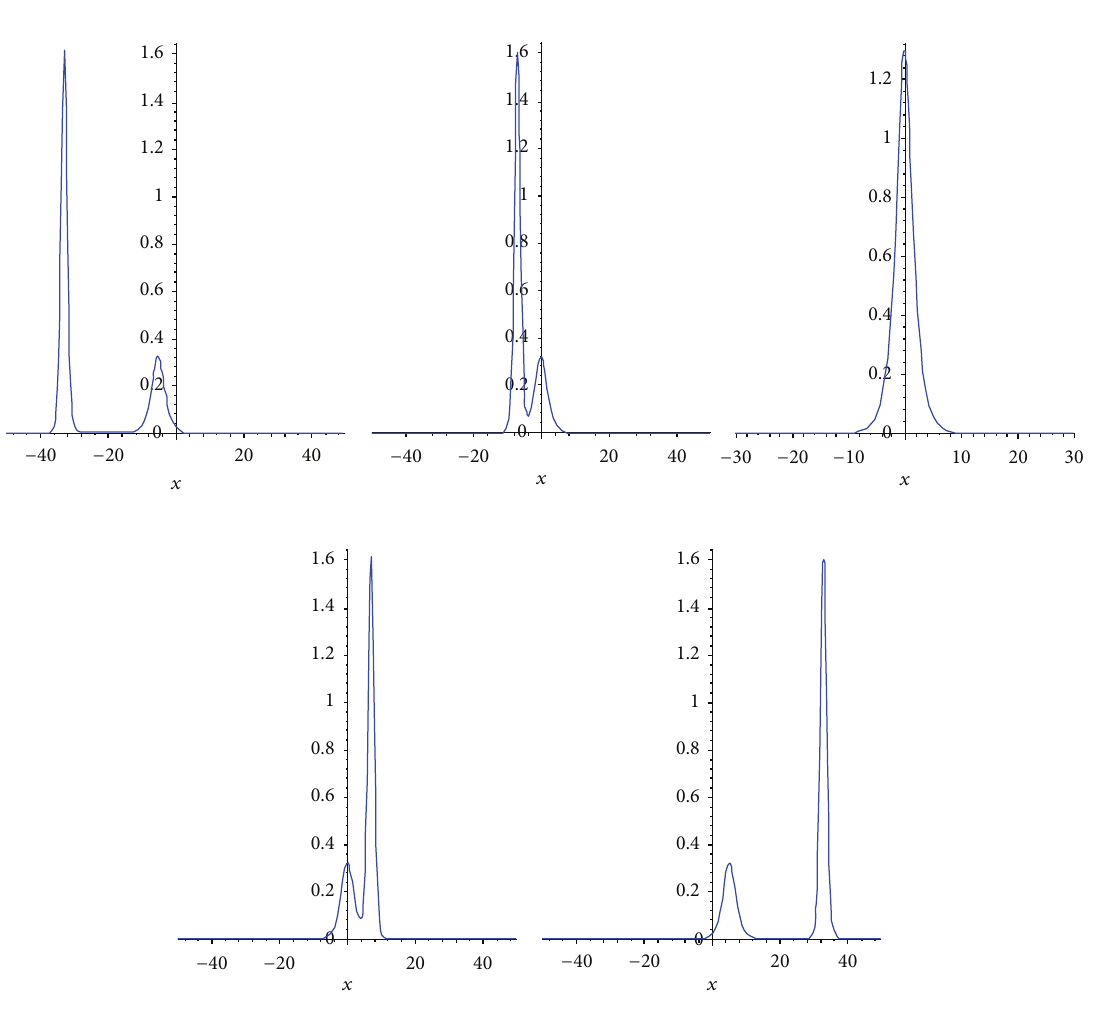
Figure 5: The interaction of two solitons for 𝑘 1 = 0.4; 𝑘 2 = 0.9; 𝑥 = −50⋅ ⋅⋅ 50; 𝑡 = −10; −2; 0; 2; 10